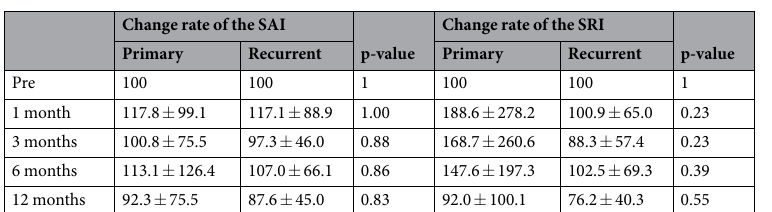
Table 3. Change rate of the surface asymmetry index (SAI) and surface regularity index (SRI) after surgery of grade 2 pterygium. All values are presented as mean ± standard deviation.